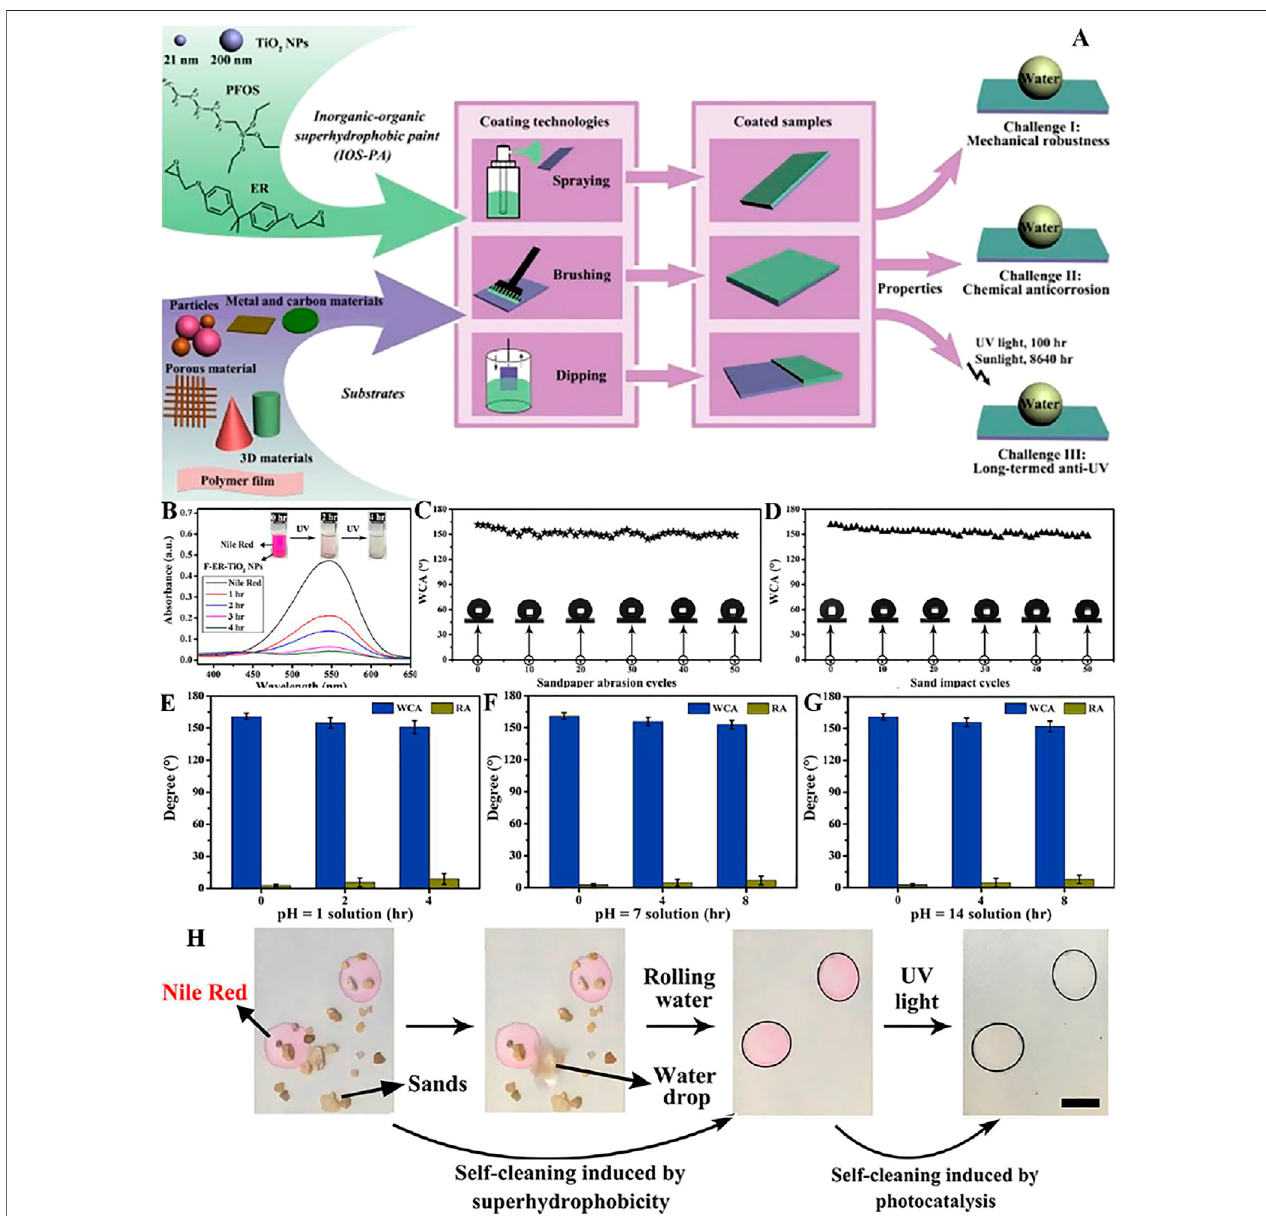
FIGURE 6 | (A) Schematic illustration of fabrication of IOS-PA. (B) UV – Vis spectra of Nile red solution showing decomposition by F-ER-TiO 2 NPs every 1 h. The insets are optical photos of the color variations. (C) The WCAs of the paint-coated surfaces were tested after each abrasion cycle, and stable superhydrophobicity was obtainedwithalmostallWCAslargerthan150 ° . (D) Aftersandimpactfor50cycles,theWCAsofthecoatingsremainedhigh,alsoshowingsuperwaterrepellency.When placedinpH=1 (E) ,pH=7 (F) ,andpH=14 (G) solutionsfor2,4,and8 h,respectively,thecoatingstillmanifestedsuperwaterrepellencywithhighWCAsandlow RCAs. (H) Multifunctionalself-cleaningwasshownonthecoating,wheresandparticlescouldberemovedbyrollingwater,andorganicdyecouldbedecomposedbyUV light (Zhu et al., 2021c).